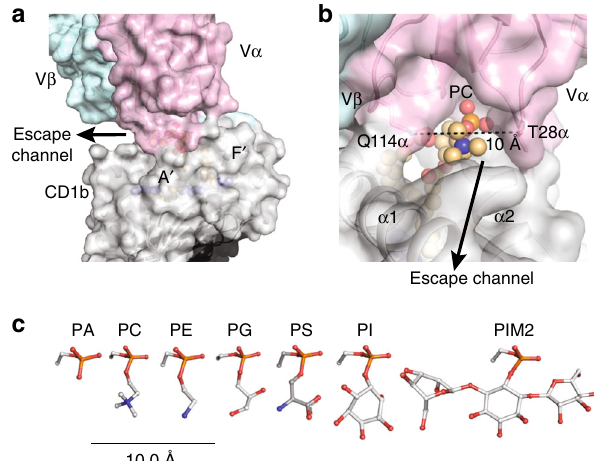
Fig. 6 The lateral escape channel of the BC8B TCR. a BC8B docking onto CD1b creates a lateral escape channel above the A ′ roof, to accommodate lipid antigen. The black arrow indicates the direction of the lateral channel opening. b The 10 Å escape channel is fl anked by T28 α and Q114 α of the CDR1 α and CDR3 α loops, respectively. Distance measurement is indicated by the black dash. Color coding for BC8B, CD1b, and the PC antigen are as in Fig. 4a. c Chemical structures of the phospholipid head groups of phosphatidic acid (PA), phosphatidylethanolamine (PE), phosphatidylglycerol (PG), phosphatidylserine (PS), phosphatidylinositol (PI), and phosphatidylinositol dimannoside (PIM2) are shown